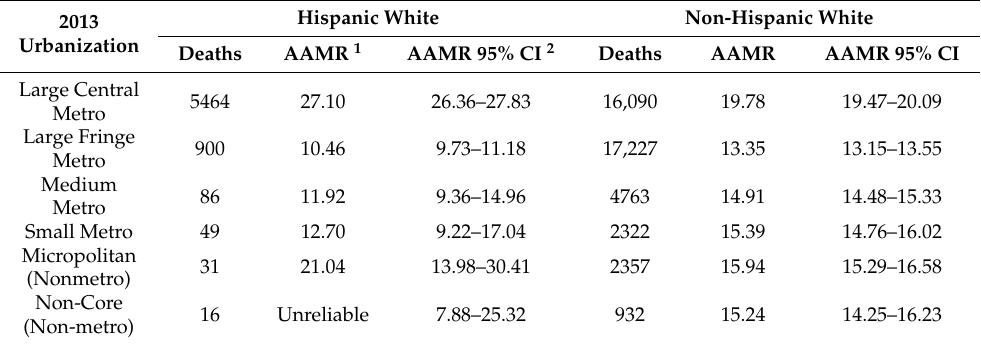
Table 2. Influenza and pneumonia deaths and age-adjusted mortality rate per 100,000 by urbanization for Hispanic whites and non-Hispanic whites in HHS Region 2 (New York and New Jersey).